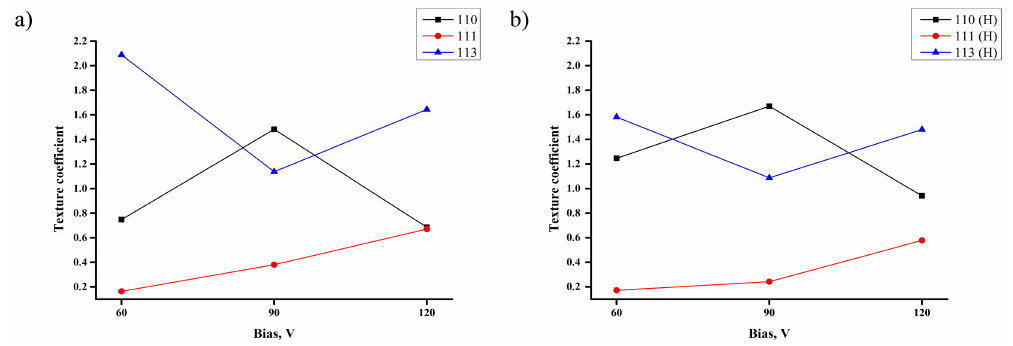
Figure 5. Texture coefficient of CrN x coatings deposited at different substrate bias ( a ) before and ( b ) after hydrogenation.